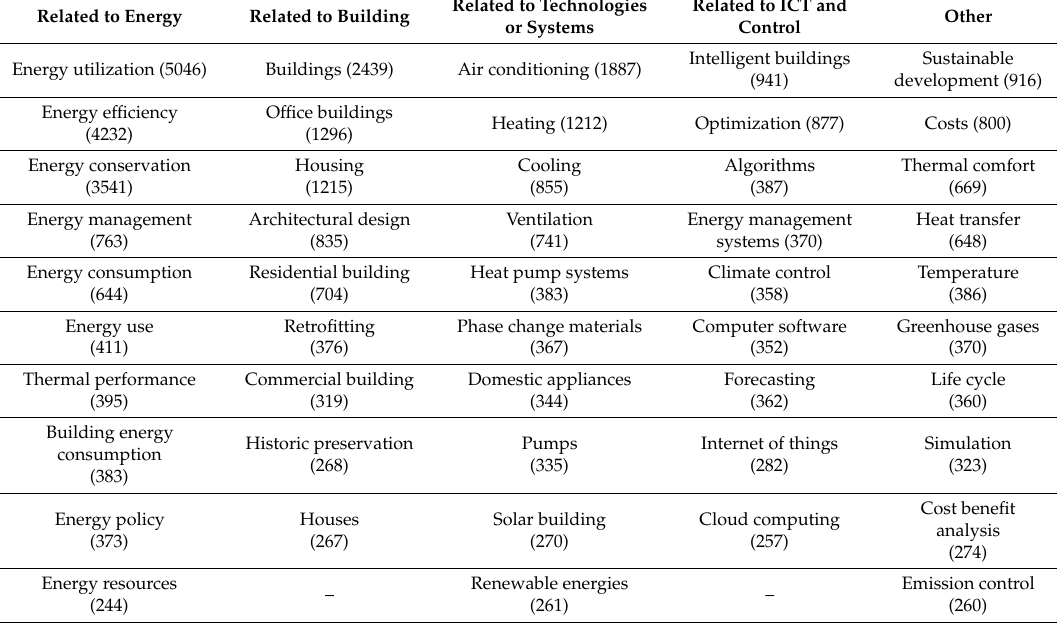
Table 3. Keywords found in the publications (in brackets the number of occurrences) according to Scopus database. The keywords are ranked in descending order of